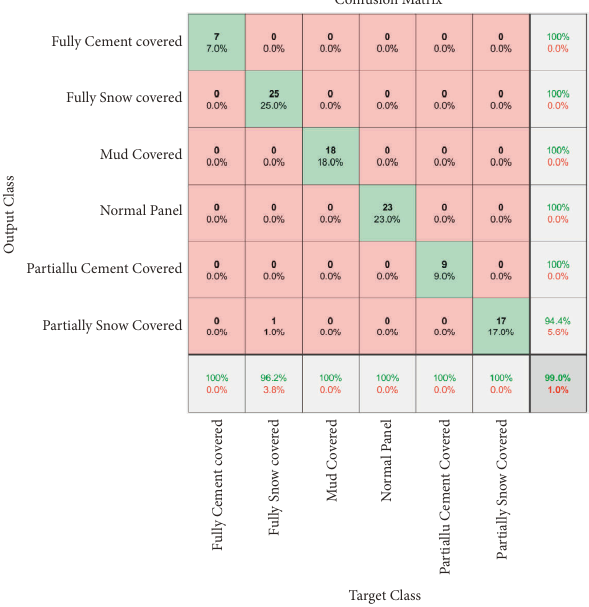
Figure 10: Confusion matrix for SqueezeNet.